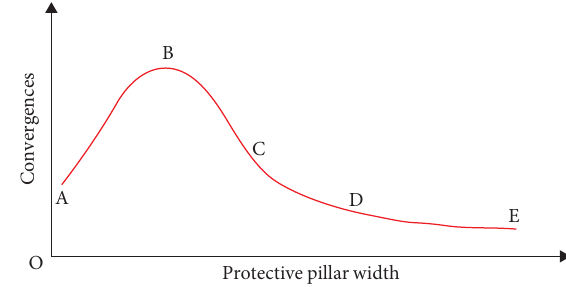
Figure 7: Stress distribution of the protective pillar [35]. (a) Single-peak distribution. (b) Double-peak distribution.